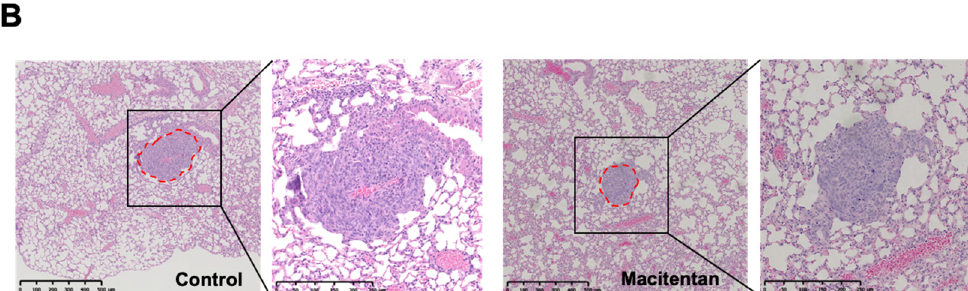
Figure 6. Macitentan treatment at a high dose reduced the number and size of lung metastatic foci. The number of metastatic nodules macroscopically detectable (arrows in ( A )) in the lung of MOS-J/PG1 tumor-bearing mice reduced significantly in the group treated with 30 mg/kg/day of macitentan compared to the untreated control group ( p = 0.0188) ( A ). Similarly, histological sections (HE staining) of the lungs showed lower sizes in the presence of macitentan ( B ). Red dotted line surrounding metastatic lung nodules in representative sections of each group ( n = 8 mice per group) enabled to measure the covered surface. * means p <